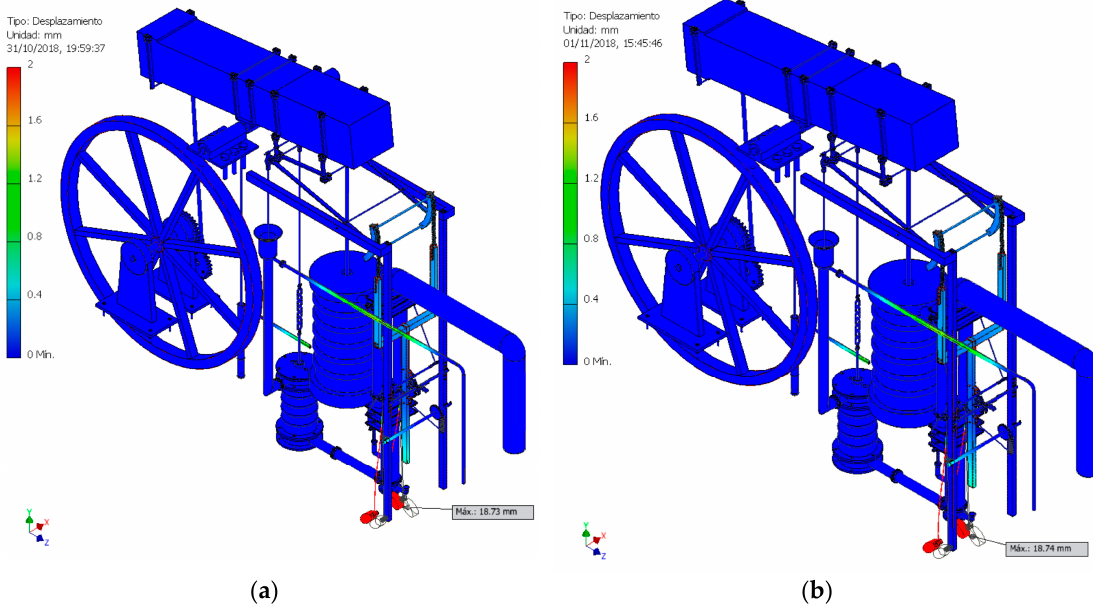
Figure 21. Displacements: ( a ) downward movement and ( b ) upward movement.